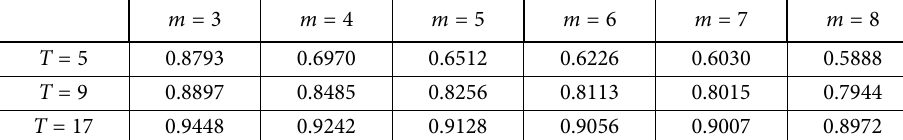
Table 1. The values of consistency thresholds CI based on different m and T m = 3 m = 4 m = 5 m = 6 m = 7 m = 8 T =